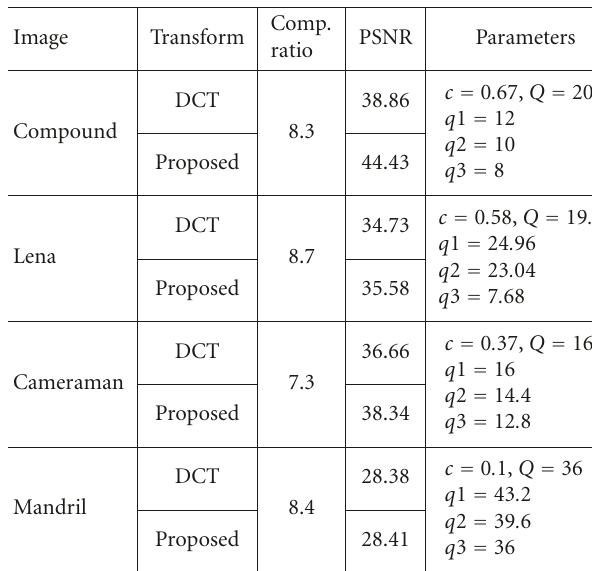
Table 2: Simulation results of Algorithm 3 (MTIC).